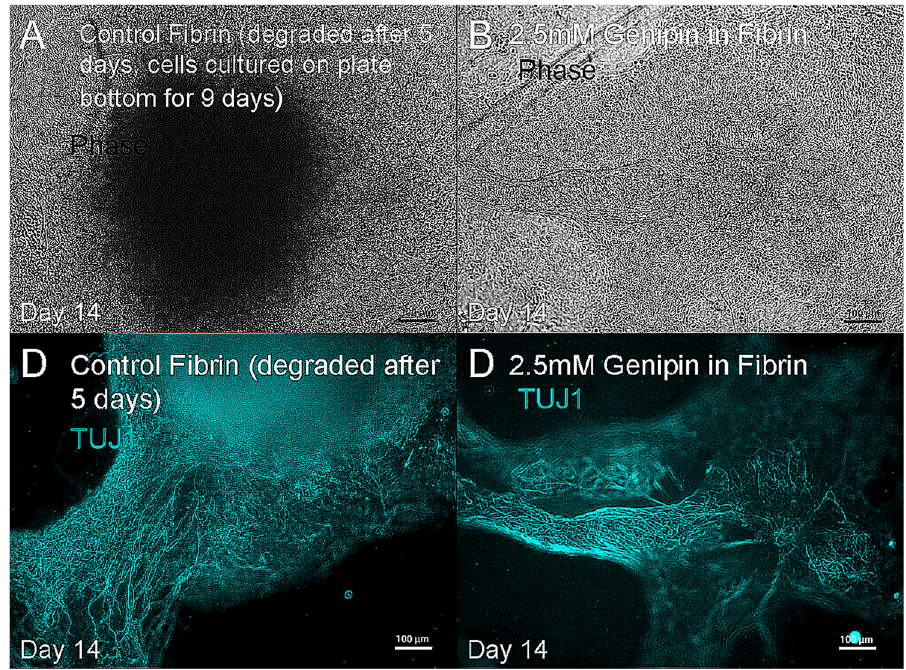
Figure 7. hiPSC-derived neural progenitors differentiate into neurons when seeded inside of mechanically stable genipin cross-linked fibrin scaffolds. ( A ) Neural aggregates seeded in fibrin degraded the fibrin within 5 days and attached to the plate bottom, whereas ( B ) neural aggregates seeded in 2.5 mM fibrin-genipin scaffolds differentiated within the 3-D scaffold which remained intact for 2 weeks. Each image represents a single neural aggregate with an initial seeding density of 4000 cells/aggregate. Image D is representative of 10 out of 24 biological replicates, which correlates with the percentage of neural aggregates showing signs of differentiation at the time of